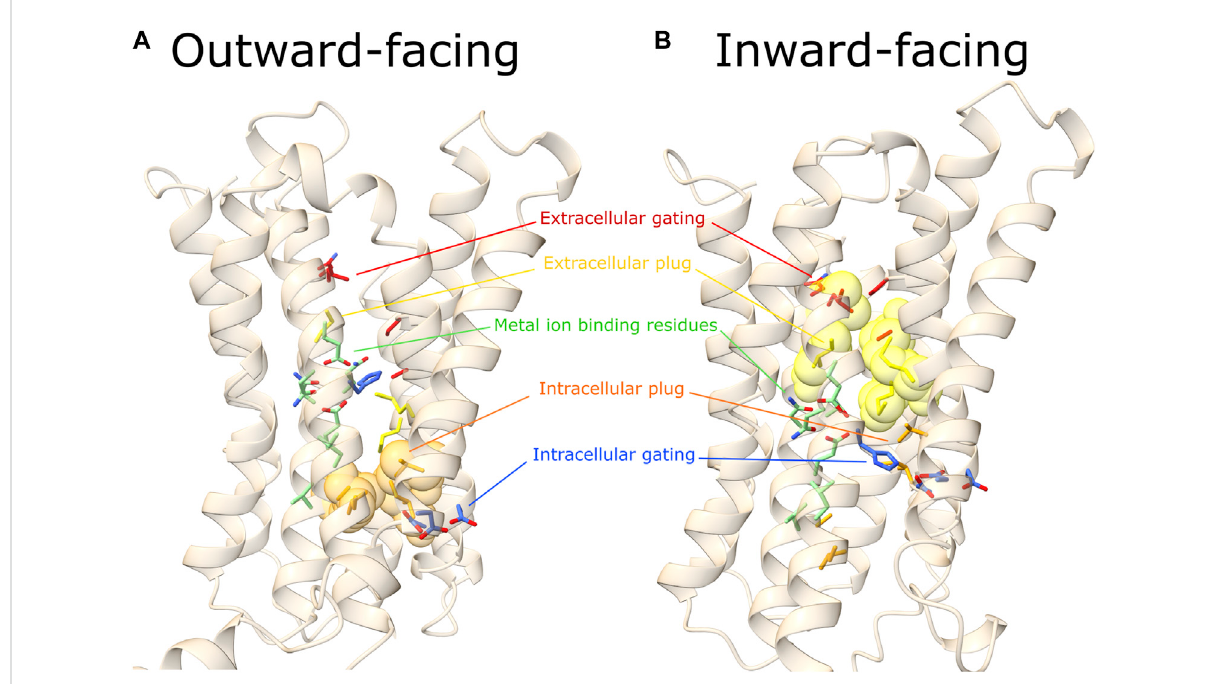
FIGURE 3 Outward- and inward-facing predicted conformations. Here are represented the outward (A) and inward (B) predicted conformations of a representative hZIP, hZIP11. In red the extracellular gating residues, in yellow the extracellular hydrophobic plug, in green residues of the TM4 and TM5 extended motifs (involved in metal ion coordination), in orange the intracellular hydrophobic plug, in blue the intracellular gating residues (see Tables 2, 3, 7,8,9)for details on hZIP11 residuesbuilding up each ofthefunctional motifs indicated).Extracellular and intracellularhydrophobic plug residues are represented as transparent spheres only in the conformational state where the barrier is